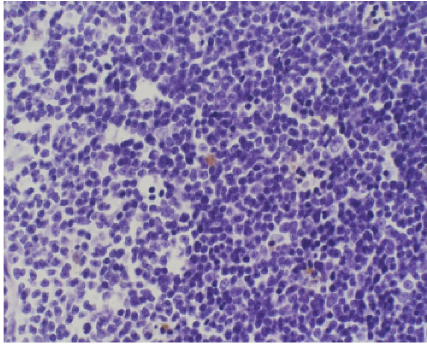
Figure 4: Model group: 12 hours; Tunel × 200.